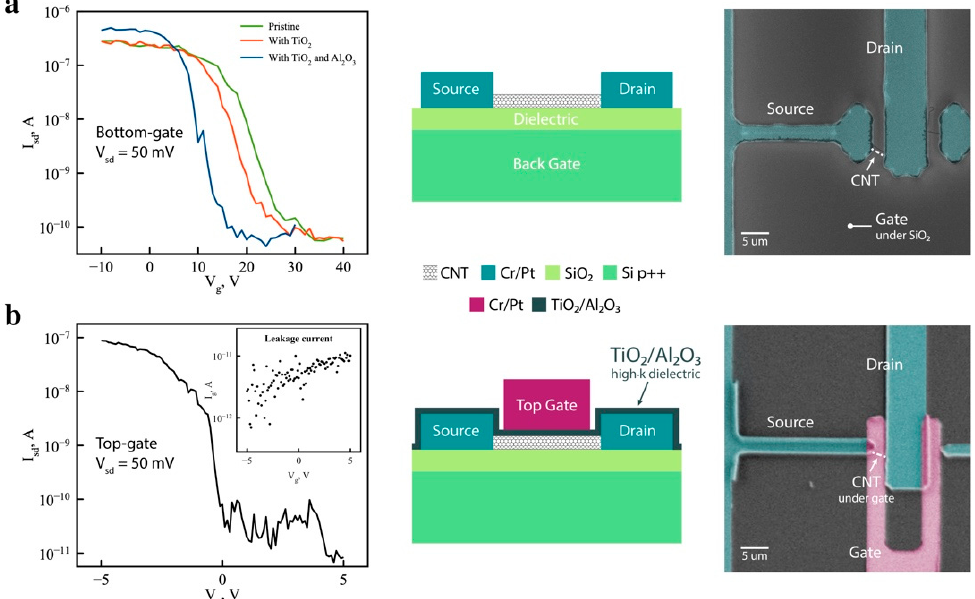
Figure 4. Electrical transport properties of CNT FETs. ( a ) Back-gated transport measurements of CNT devices, uncoated (pristine-green), with TiO 2 only (red), and with TiO 2 and Al 2 O 3 (blue). A schematic illustration of the device geometry is shown (center), and a false-colored SEM image (right); ( b ) hole transport in top-gated CNT transistor. Insets in shows the leakage current. A schematic illustration of the device geometry is shown (center), and a false-colored SEM image (right).